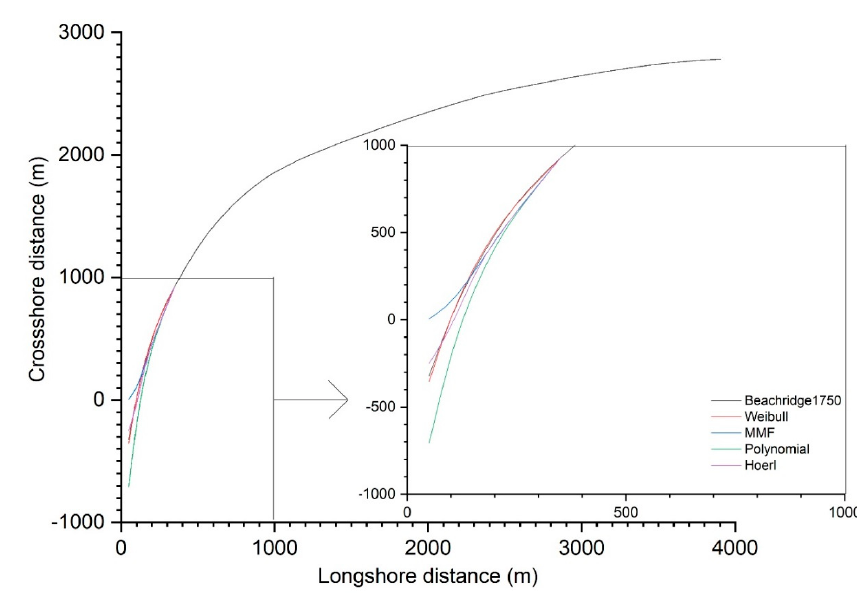
Figure 5. Real beach ridge 1750 ca., correlated to a progradation period, with the four best fitting mathematical functions.